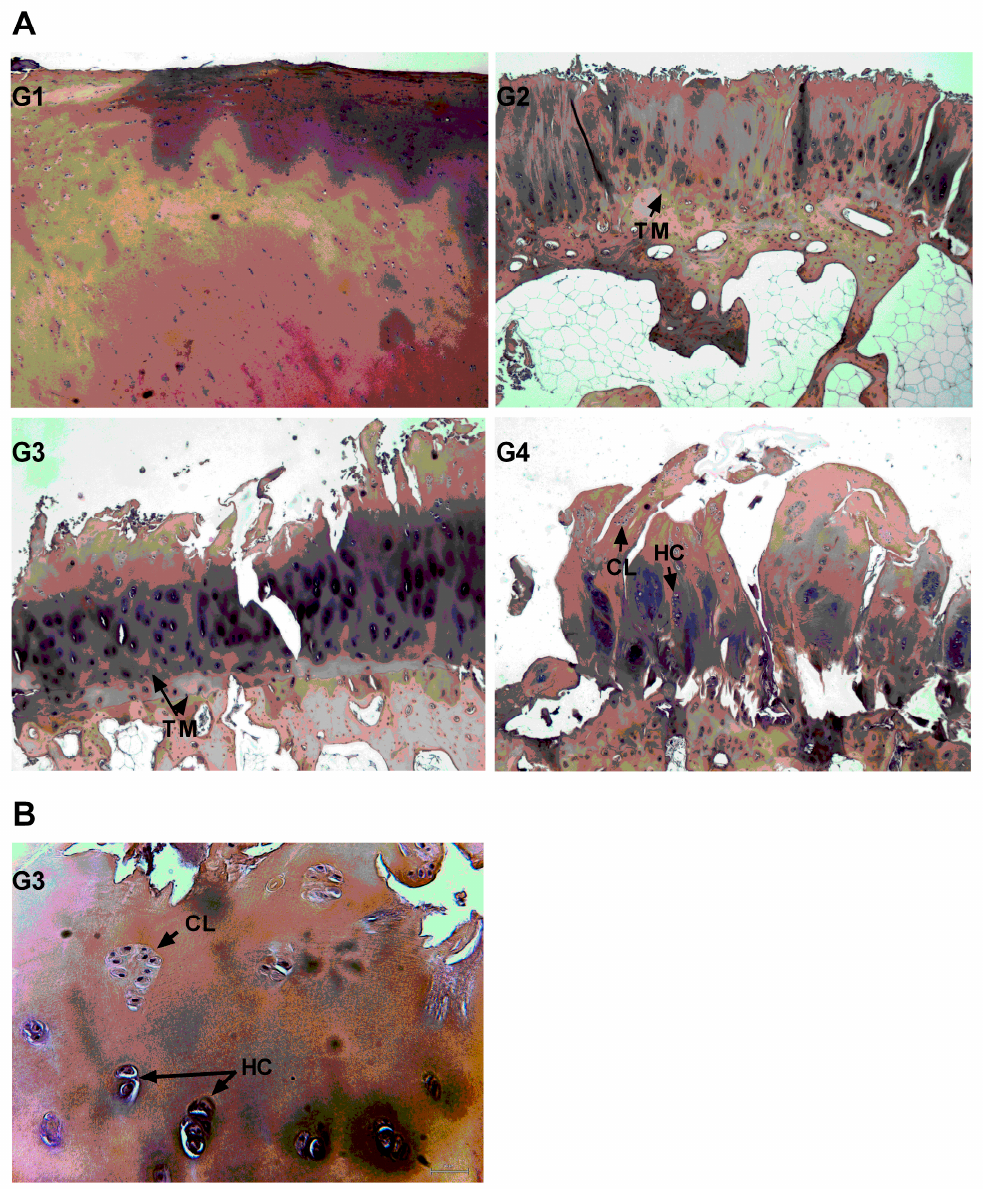
Figure 1. OARSI scoring assessment of specimen. ( A ) HES stained sections of cartilage at different grades of degradation-Grade 1/G1: superficial fibrillation and cells death; Grade 2/G2: matrix depletion in superficial and middle zone and disorientation of chondrocytes columns (black arrows); Grade 3: matrix vertical fissures into mid zone, formation of the chondrocytes clusters and hypertrophic chondrocytes (black arrows); Grade 4: loss of superficial and mid zone of cartilage, increase in the number of clusters and hypertrophic chondrocytes (black arrows) (4 × ); ( B ) Chondrocytes clusters and hypertrophic chondrocytes (20×).